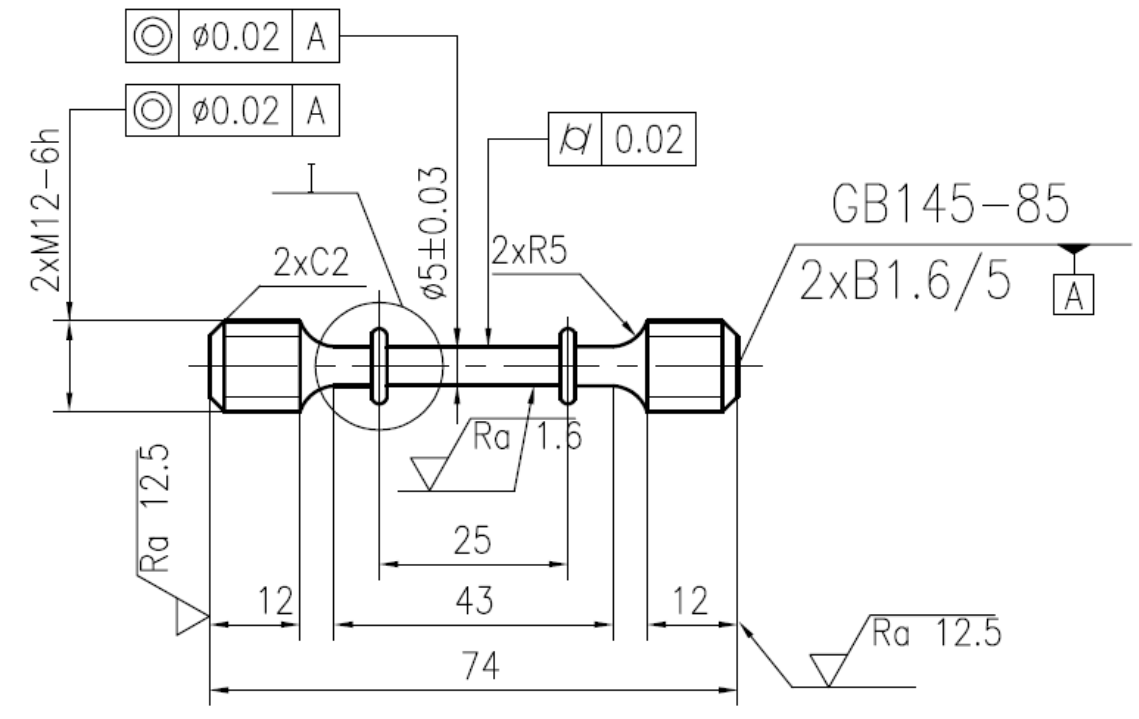
Figure 1. Schematic of the creep specimen (Unit: mm).